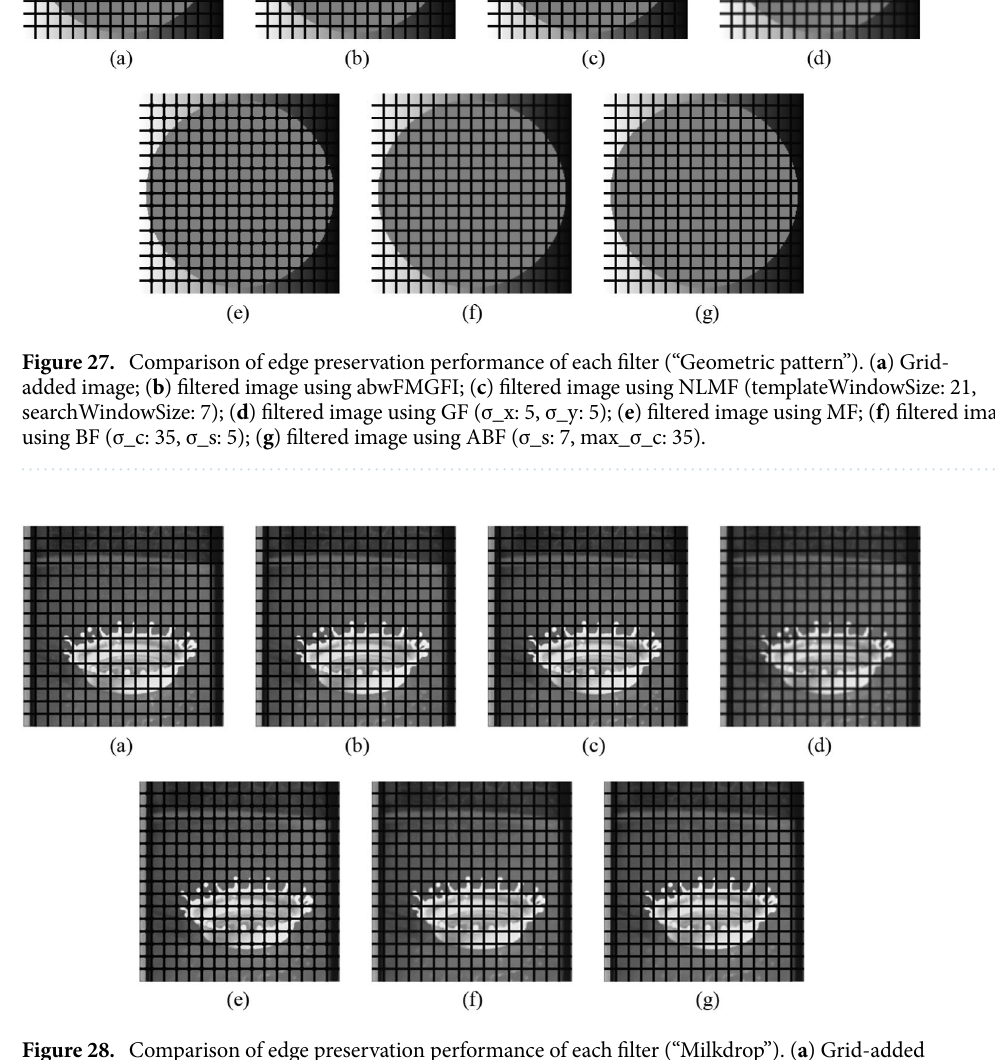
Figure 28. Comparison of edge preservation performance of each filter (“Milkdrop”). ( a ) Grid-added image; ( b ) filtered image using abwFMGFI; ( c ) filtered image using NLMF (templateWindowSize: